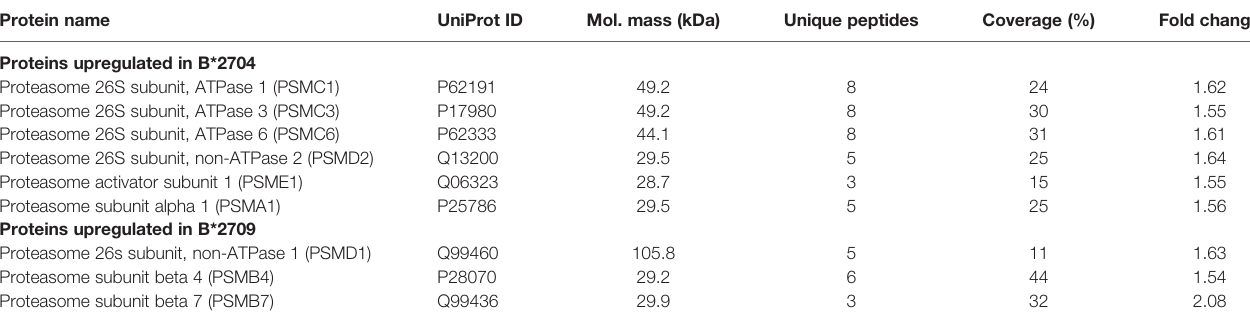
TABLE 2 | Statistically signi fi cant, differentially expressed proteins classi fi ed under the KEGG pathway, “ Proteasome ” . Protein